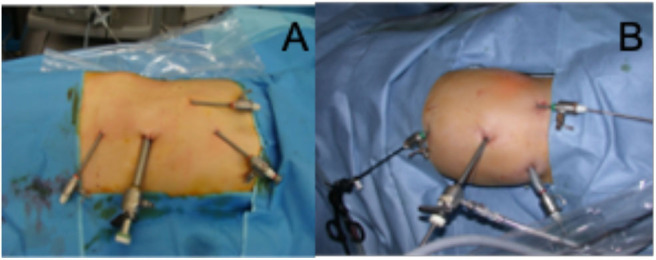
(A) Placement of the four trocars in older children: all in the midline; (B) Placement of the four trocars in young children.